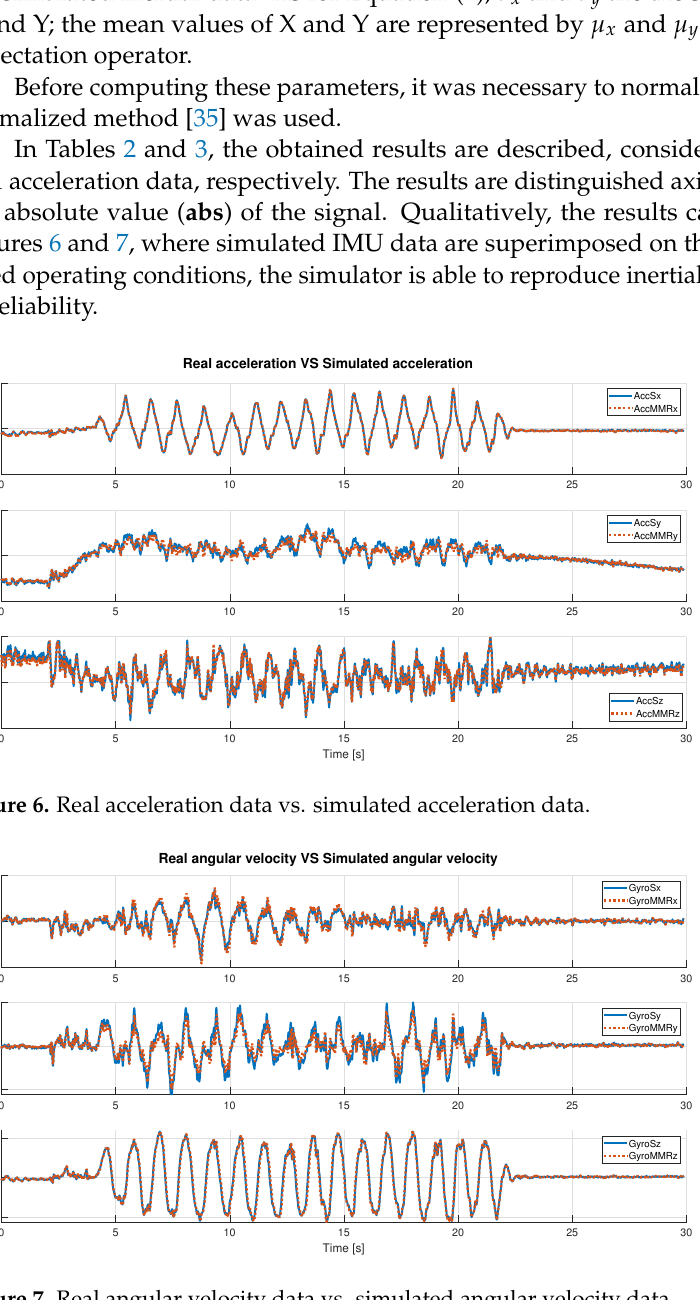
Figure 7. Real angular velocity data vs. simulated angular velocity